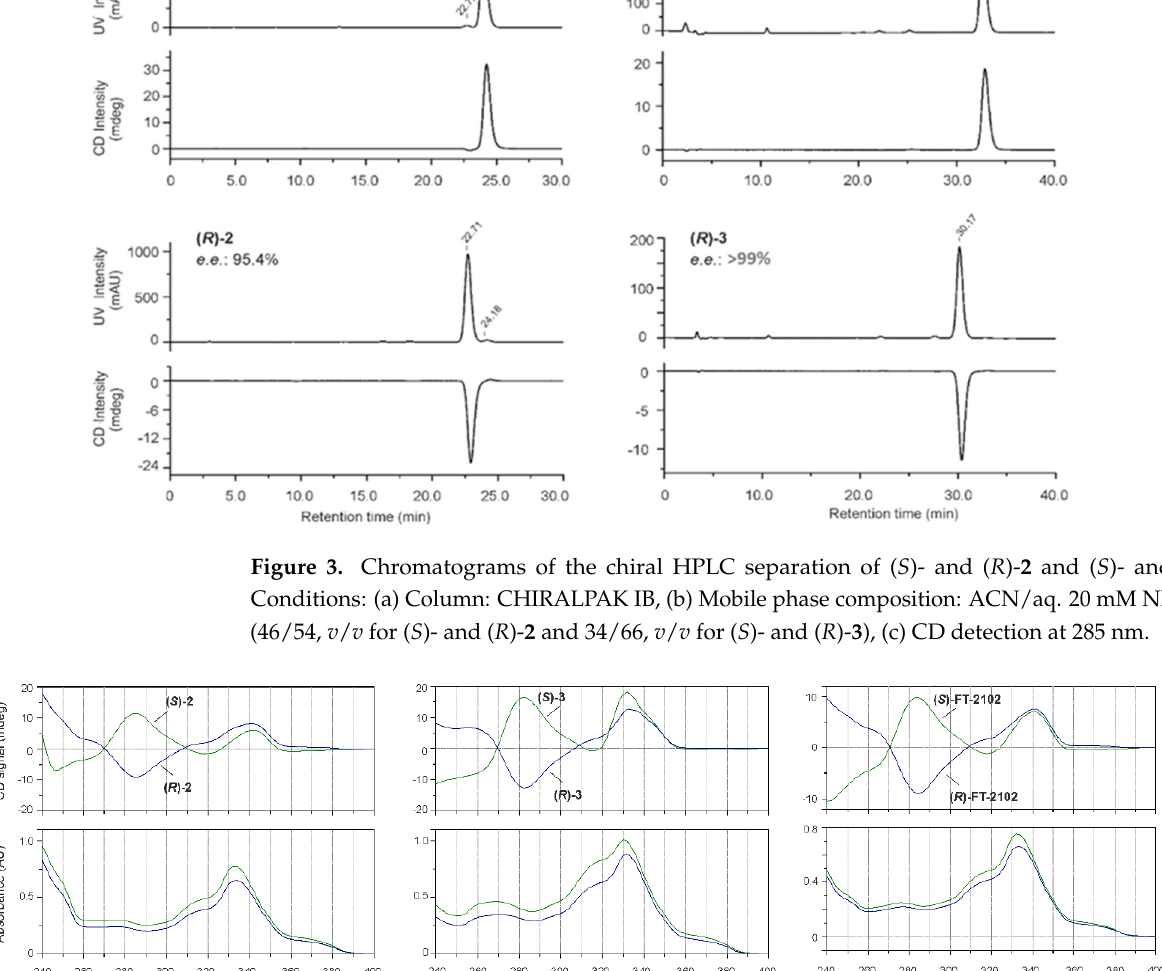
Table 1. Overview of synthesised derivatives and their inhibition potency towards mIDH1 and wt IDH1/2.